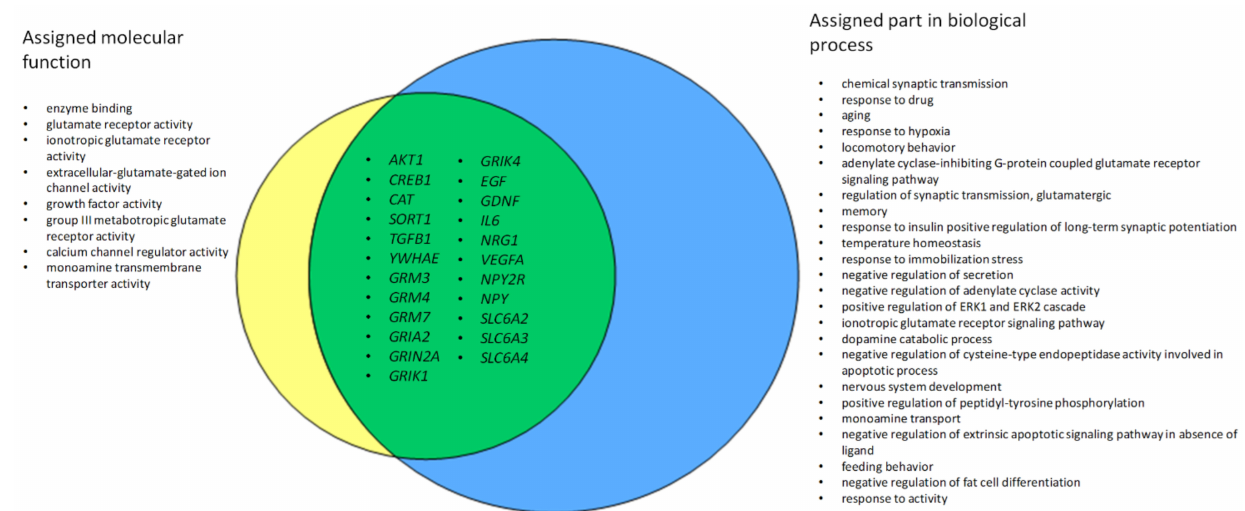
Figure 3. Overlapped genes from molecular function and biological process enrichment analysis associated with